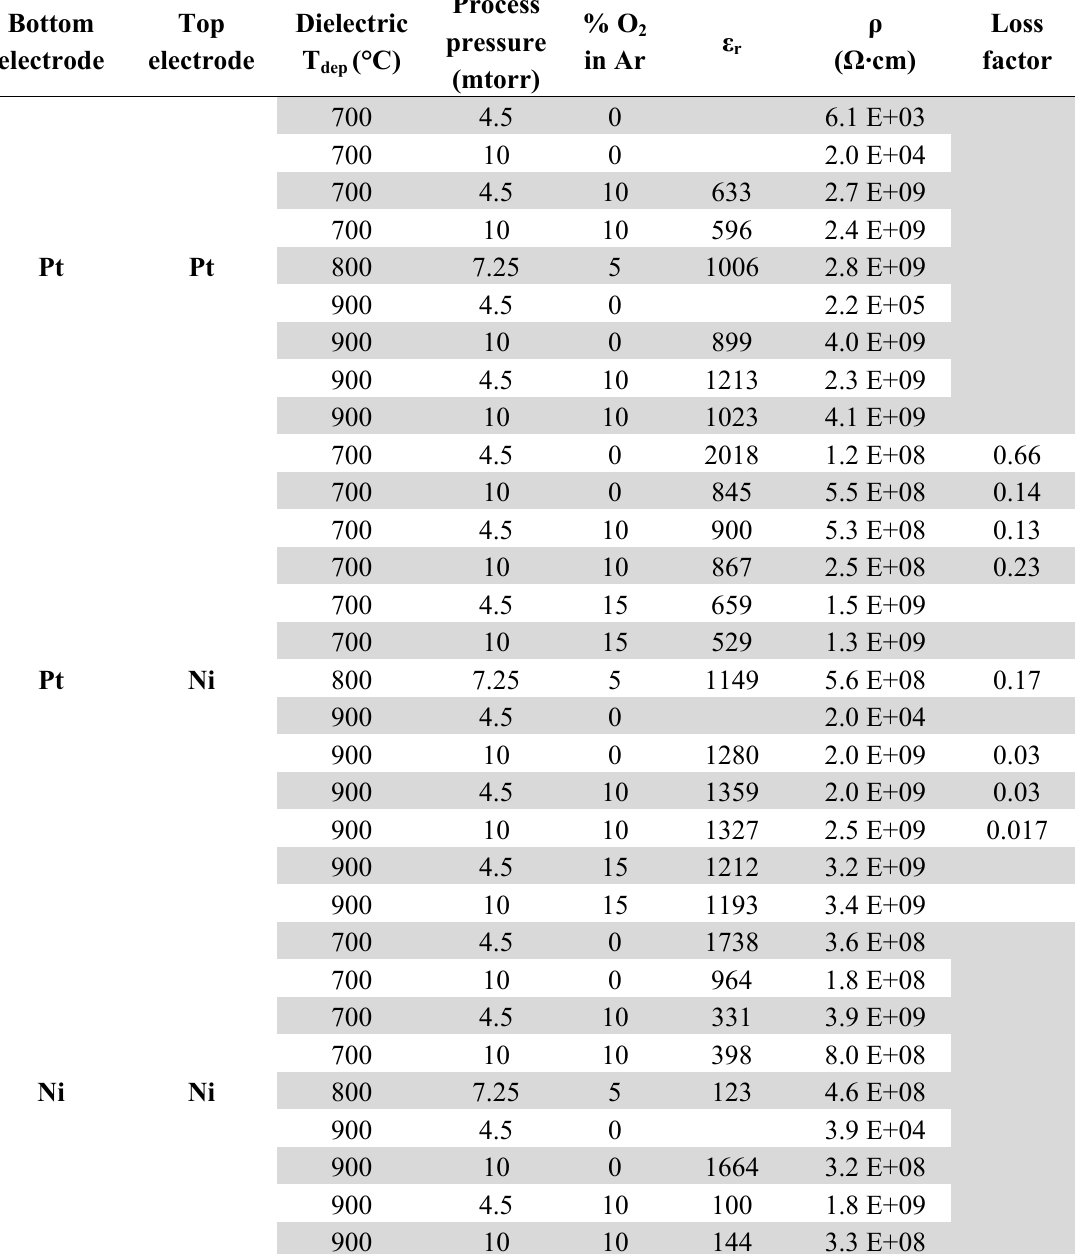
Table 2. Selected electrical properties (50 mV, 20 Hz) of BCZTO thin-film capacitors as a function of electrode material and dielectric deposition